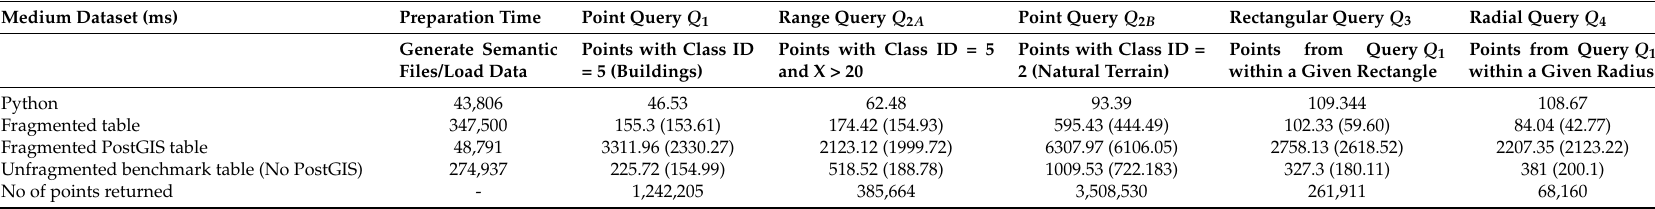
Table 5. The preparation time along with the query times (in milliseconds) for five queries using the MEDIUM dataset. The fragmented table (without PostGIS) clearly provides for the fastest queries among the PostgreSQL approaches, even outperforming the Python approach for queries Q 3 and Q 4 .